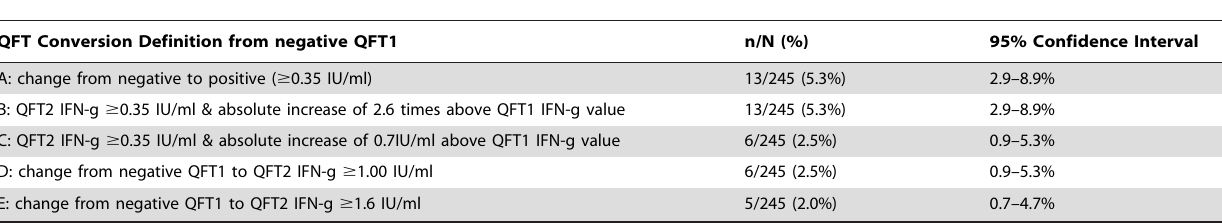
Table 2. QFT Conversion rates using manufacturer’s recommended and alternative conversion